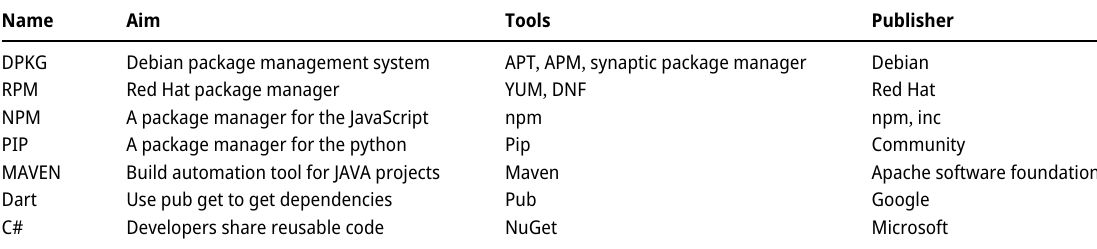
Table 3: Some package management